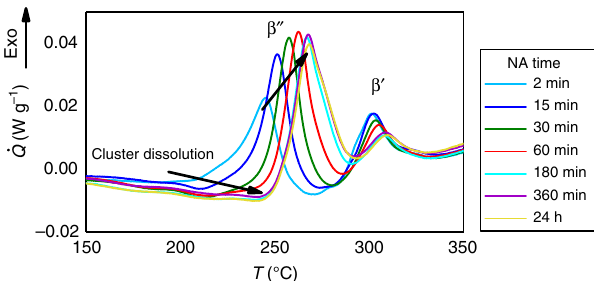
Fig. 1 Excess heat fl ow (DSC heating curves) at varying NA times after quenching of an AlMgSi alloy. Increasing NA time progressively increases cluster dissolution and delays the formation of the main hardening precipitate ( β 00 ) upon